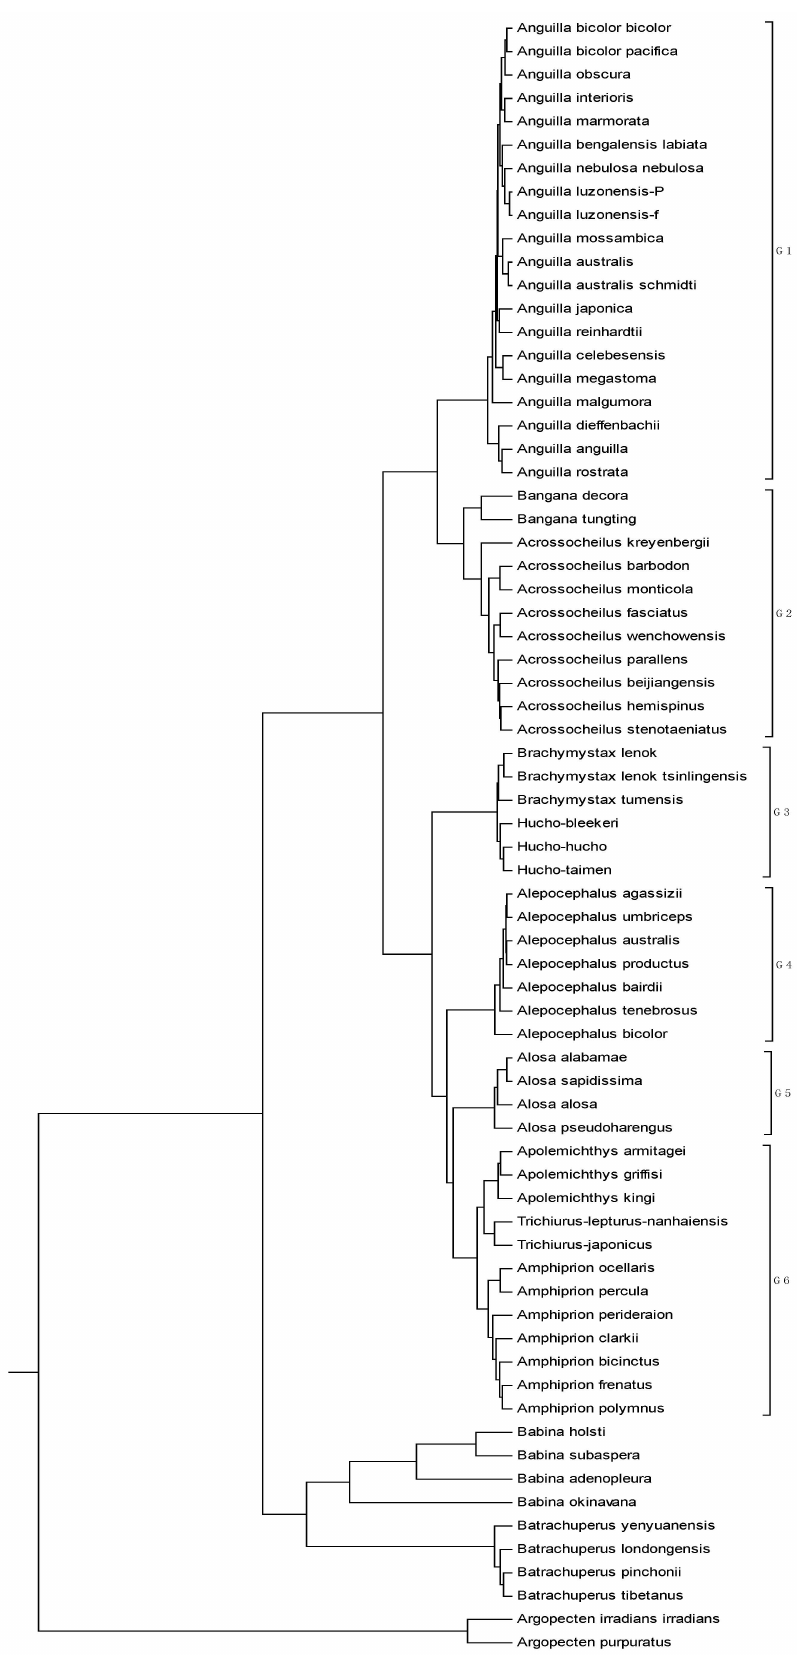
Figure 6. The tree of 70 genome sequences constructed with the current